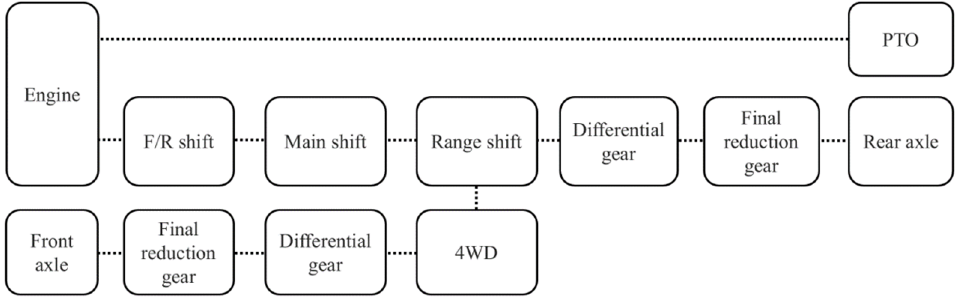
Figure 4. Power flow of the 86 kW class agricultural tractor used in this study.